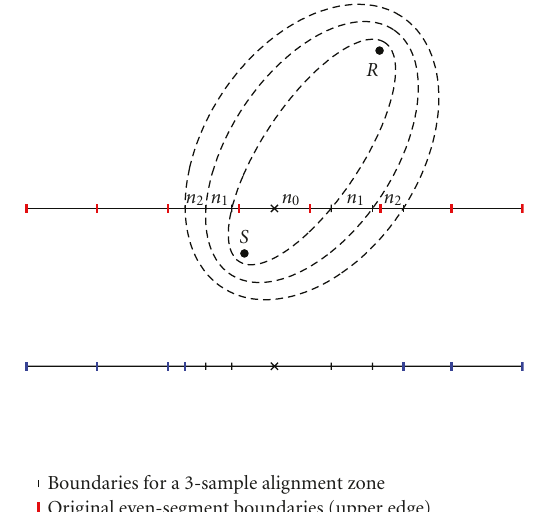
Figure 2: Unfolded 2D view of a source, receiver, and segmented edge. The upper edge is marked with the boundaries for a 3-sample alignment zone (samples n 0 , n 1 , and n 2 ) in black and the origi- nal even-segment boundaries in red. The lower edge ( S and R not shown) is marked with the modified segment boundaries for the hybrid subdivision scheme in blue: even segments overlapping the alignment zone have been truncated at the edges of the zone, and those completely within the alignment zone have been discarded. The apex point is marked with an